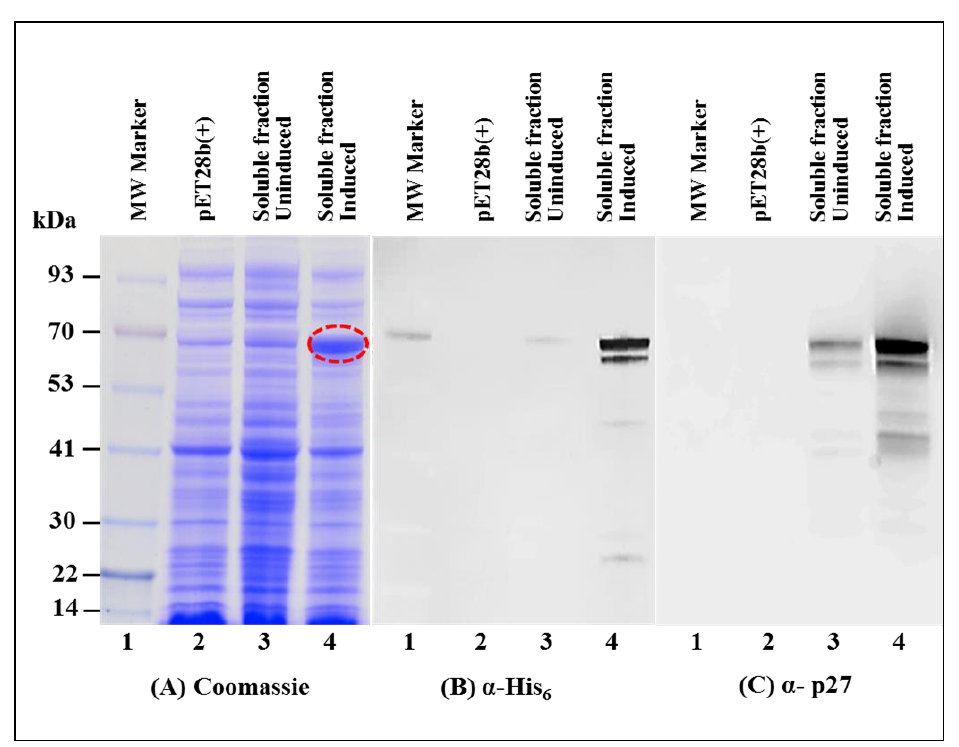
Figure 3. Recombinant Pr77 Gag -His 6 -tag fusion protein expressed in soluble fraction of E. coli . ( A ) SDS-PAGE analysis showing recombinant MMTV Pr77 Gag -His 6 -tag fusion protein expression in the bacterial soluble fraction (lane 4) transformed with AK1; ( B ) western blot analysis of MMTV Pr77 Gag expression by AK1 in soluble fraction analyzed with an α -His 6 monoclonal antibody (lane 4); and ( C ) with an α -p27 monoclonal antibody (lane 4), respectively.